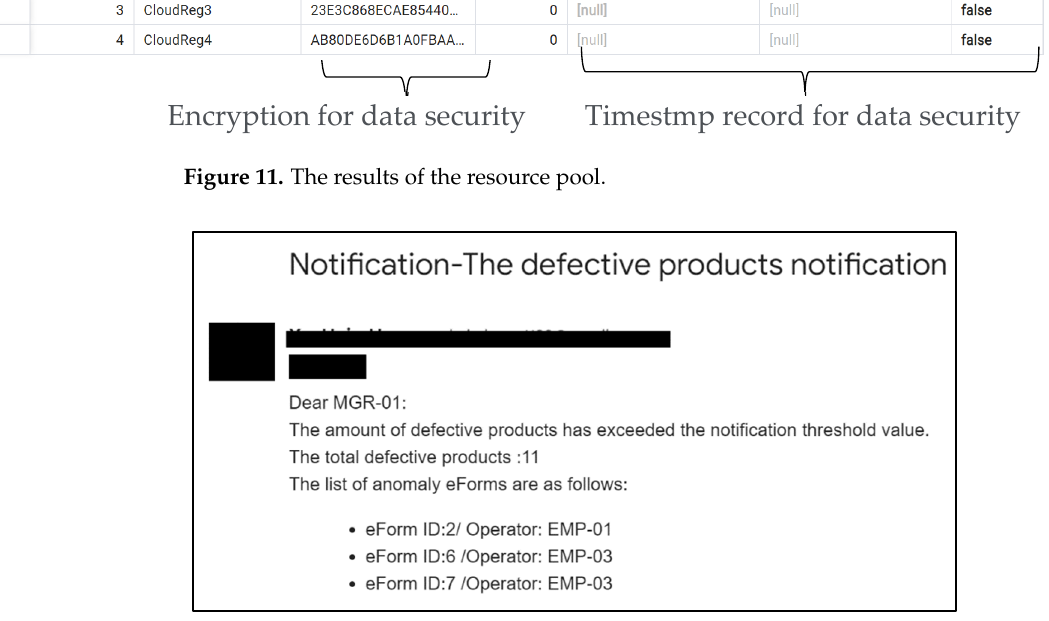
Figure 12. The result of automatically notification via the distributed emailing resource.